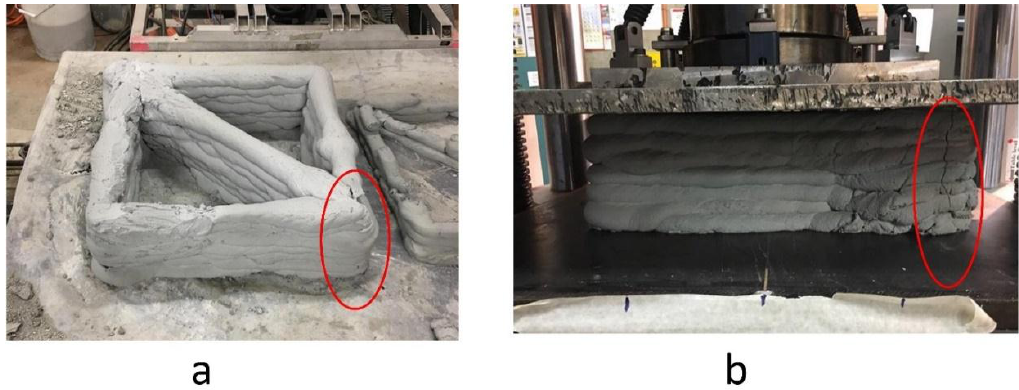
Figure 19. ( a ) The printed specimen after drying at lab temperature; ( b ) the printed specimen under uniaxial load.